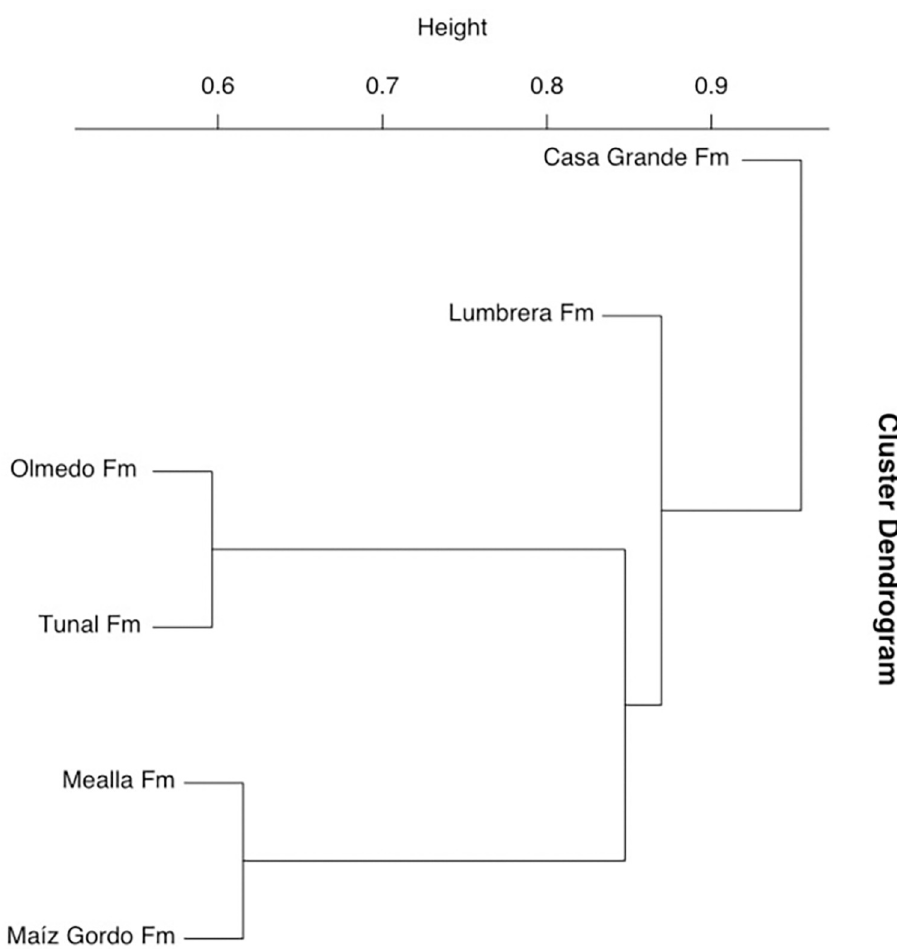
Fig 9. Cluster dendrogram. Hierarchical clustering showing the similarities among the spore-pollen records from the Casa Grande 1 sequence (this study) and those previously published from other nearby Paleogene sites based on presence/absence data (S2 Table). The number of samples and morphotypes of each site is given in Materials and Methods. The heterogeneity of either the fossil record and the sampling effort may influence the outcome of the hierarchical clustering, hence results should be interpreted